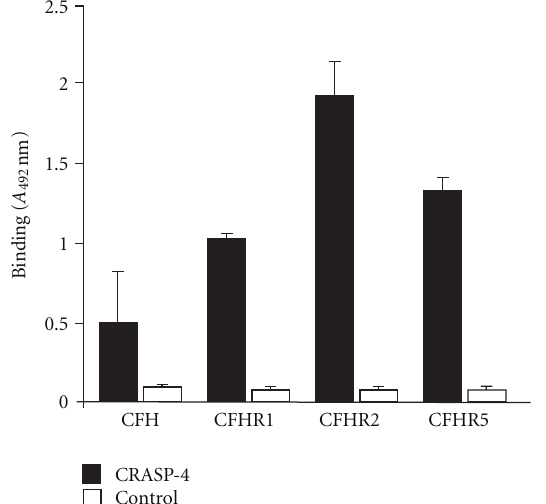
Figure 2: CRASP-4 binds distinct complement proteins. Binding of equimolar amounts of CFH, CFHR1, CFHR2, and CFHR5 (33 μ M) to immobilized CRASP-4 (5 μ g/mL) was analyzed by ELISA. Bound CFH or CFHR proteins were detected with either goat CFH polyclonal antiserum or mouse CFHR1 monoclonal antiserum (JHD 7.10), which reacts with all three CFHRs. Data represent the means and standard errors from three separate